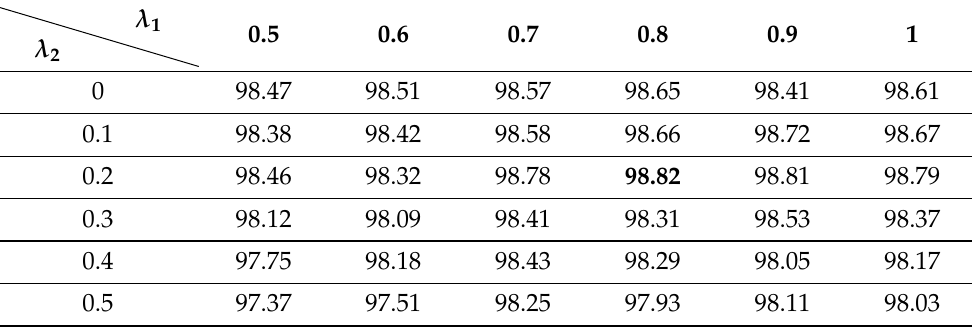
Table 8. Overall accuracy in the Salinas data set with different λ 1 and λ 2